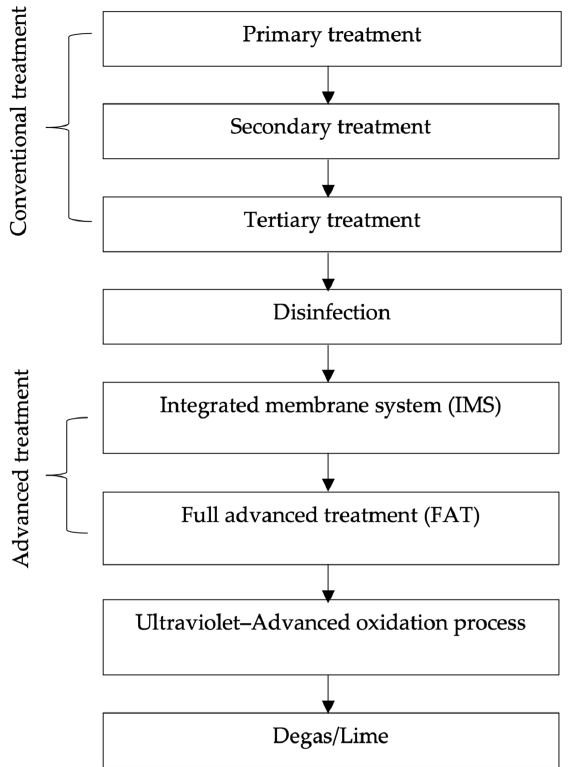
Figure 2. Industry ‐ standard potable reuse plant. Figure 2. Industry-standard potable reuse